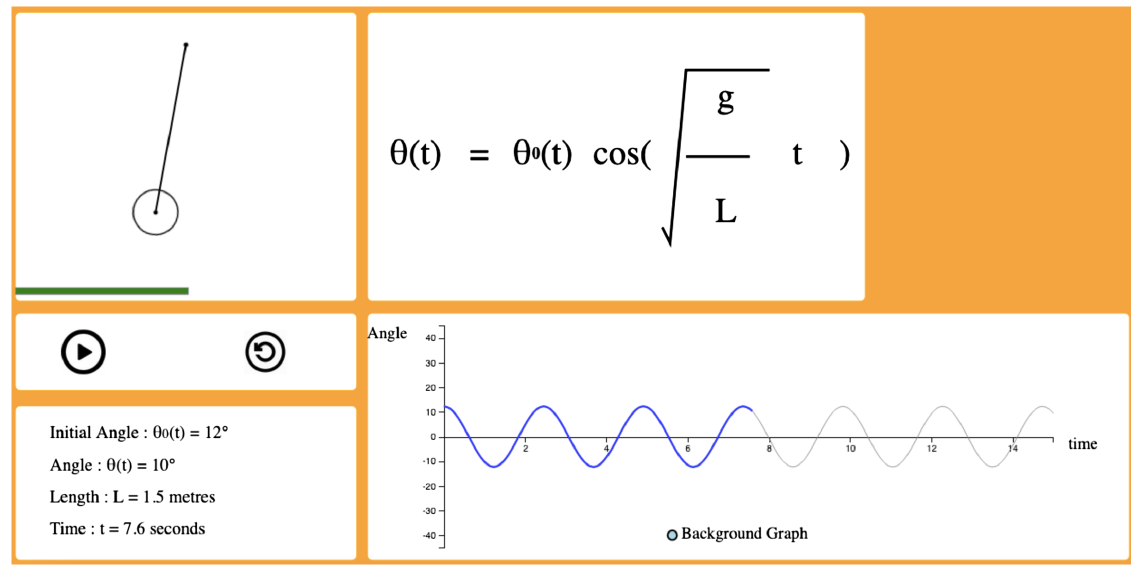
FIG. 4. A snapshot of the bridge simulation based on the simple pendulum (for access, see, Pendulum Ref. [61]). The schematic and the equation can be manipulated interactively, and the simultaneous changes in the graph can be